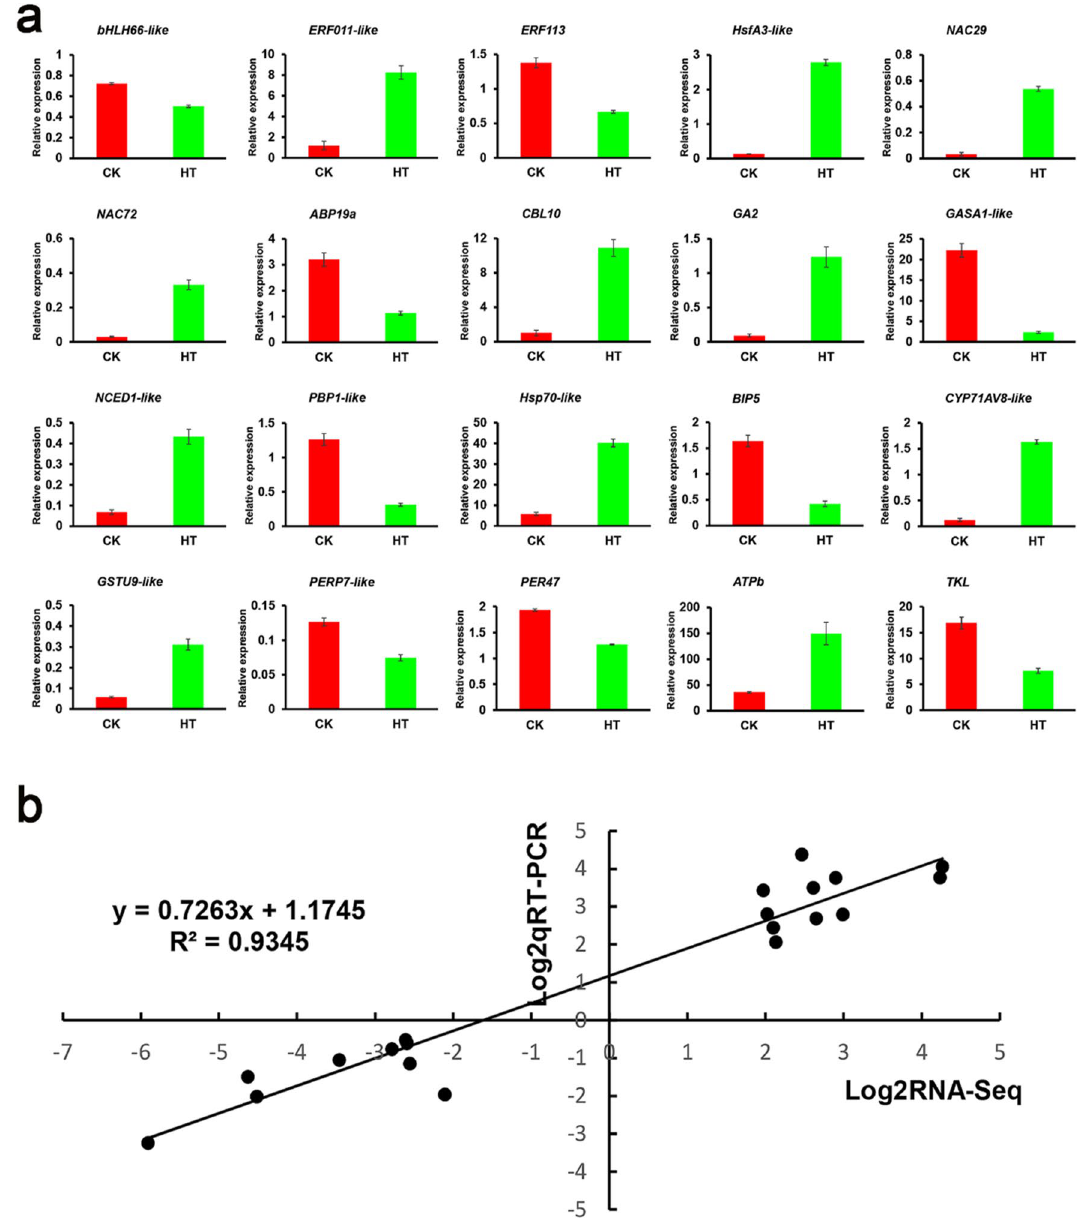
Figure 10. Relative gene expression of DEGs analyzed by quantitative RT-PCR in response to high-temperature stress treatment. ( a ) quantitative RT-PCR data were normalized using the S. pohuashanensis Actin β gene and are shown relative to CK (normal condition). X-axes show different treatments (CK, normal condition and HT, high temperature condition) and Y-axes are scales of relative expression level (error bars indicate SD). ( b ) Correlation of expression levels between RNA-seq and qRT-PCR that identified 20 HT vs. CK. The log 2 qRT- PCR (y-axis) was plotted against log 2 RNA-seq